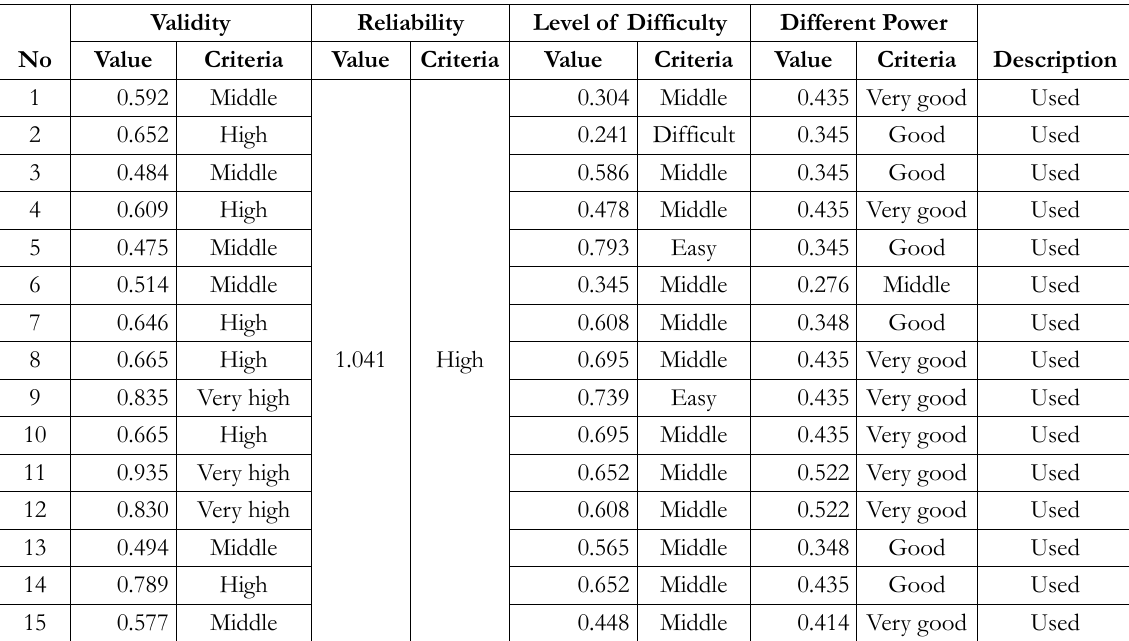
Table 1. The results of instrument test of multiple choice tests